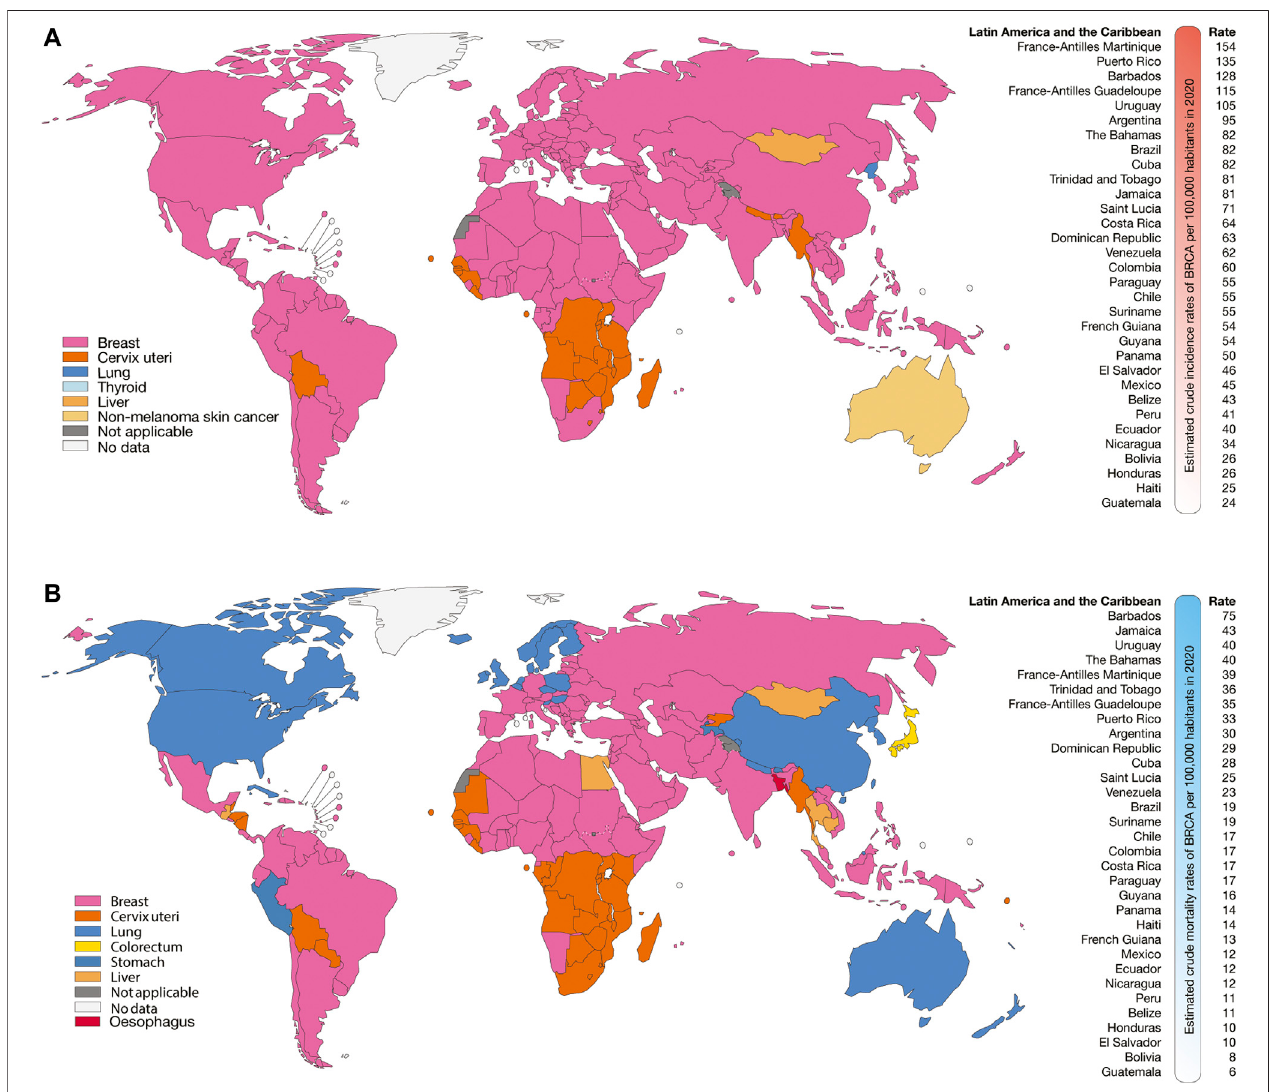
FIGURE 1 | Epidemiology of BRCA. (A) Top cancer crude incidence per country in females of all ages (left) , and ranking of estimated crude incidence rates of BRCA per 100,000 inhabitants in Latin American and the Caribbean countries (right) . (B) Top cancer mortality per country in females of all ages (left) , and ranking of mortality crude rates of BRCA per 100,000 inhabitants in Latin American and the Caribbean countries (right)